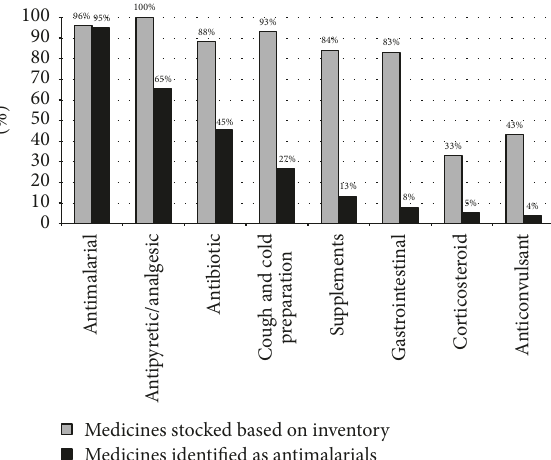
Figure 2: The array of medicines stocked by outlets and those vendors identified as antimalarial ( 𝑛 = 75 ). Drug vendors provided multiple responses. Only those outlets with more than 33% of a stocked medicine are represented in the